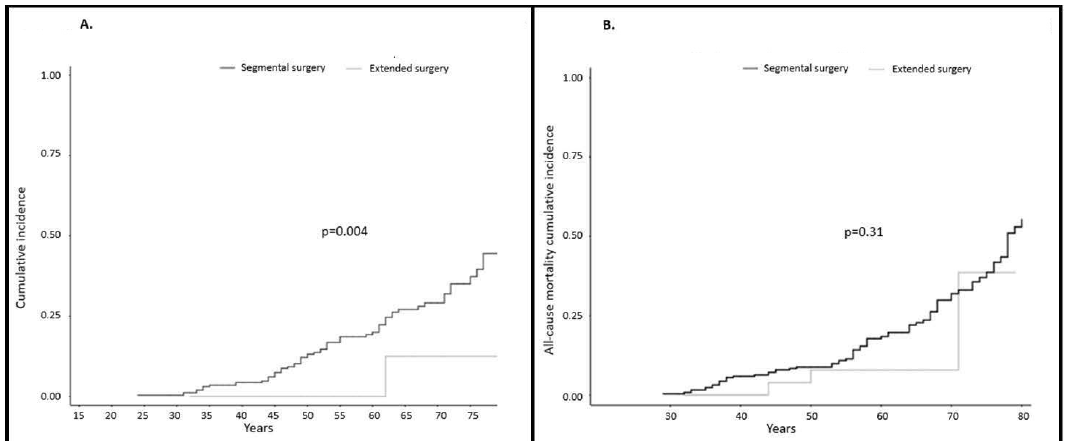
Figure 1. Colorectal cancer cohort: ( A ) Cumulative incidence at 75 years of metachronous colorectal cancer in Lynch syndrome subjects comparing extended surgery and segmental surgery: Cumulative incidence at 75 years of metachronous colorectal cancer was 12.5% for extended surgery vs. 37.3% for segmental surgery ( p = 0.004); ( B ) All-cause mortality cumulative incidence in Lynch syndrome subjects comparing extended surgery and segmental surgery: All-cause mortality cumulative incidence was 38.6% for extended surgery vs. 55.3% for segmental surgery ( p =